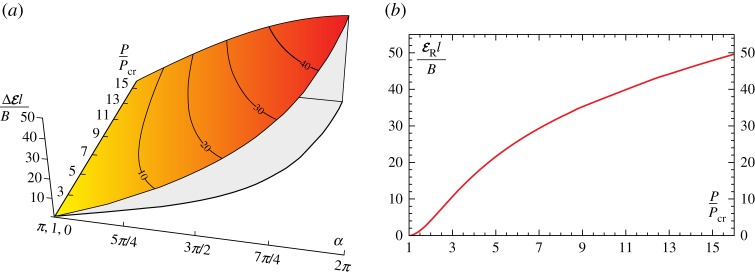
Energy difference ΔE, equation (6.1), normalized through division by B/l, as a function of the load ratio P/Pcr and the clamp inclination α (a). Energy release ER at snap-back (α=αs), equation (6.5), as a function of the load ratio P/Pcr (b). (Online version in colour.)